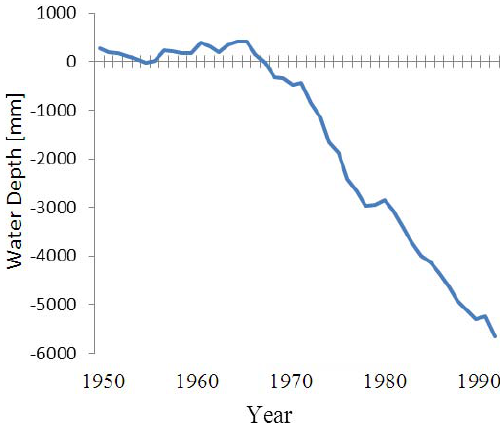
Fig. 9. Accumulative aquifer storage